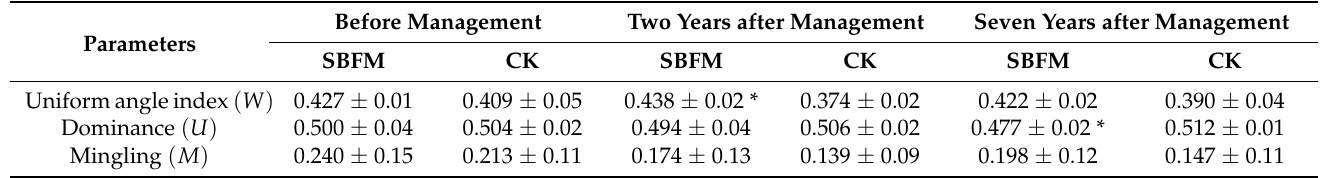
Table 2. The average values of SSSPs of